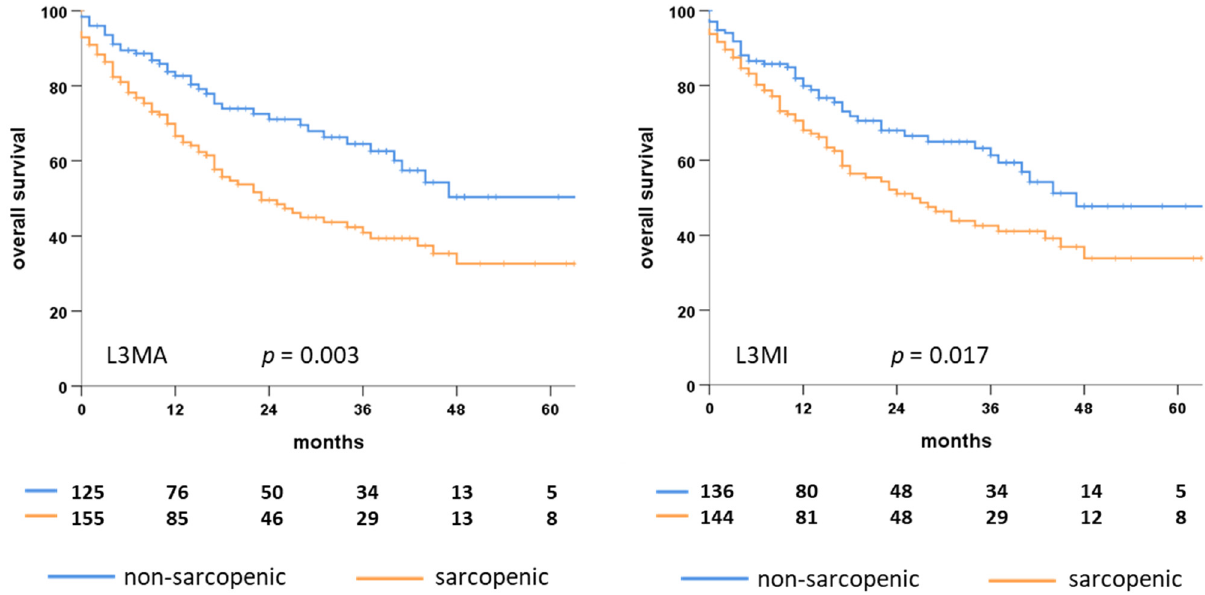
Figure 3. Kaplan Meier plots showing overall survival of pretherapeutic sarcopenic (orange) and non-sarcopenic (blue) elderly HNSCC patients classified for L3MA (left plot) and L3MI (right plot). L3MA, calculated cross-sectional skeletal muscle area at the third lumbar vertebra; L3MI, calculated skeletal muscle index at the third lumbar vertebra; p , p -value; HNSCC, head and neck squamous